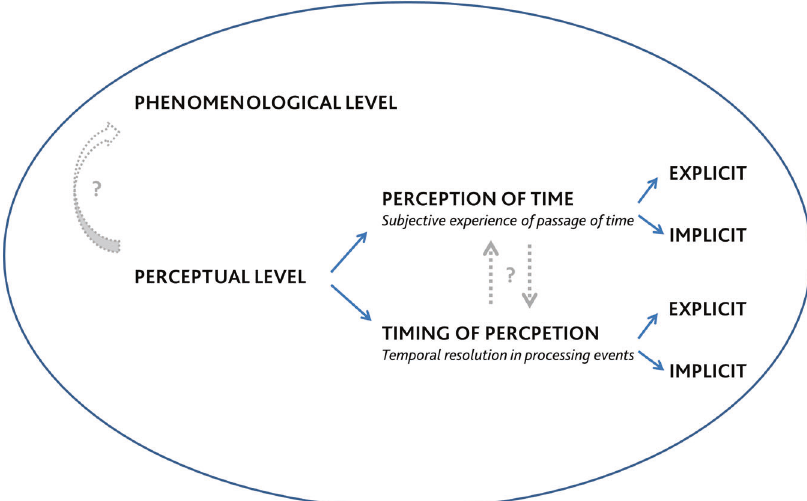
Fig. 1 The concept of time. Time involves both a phenomenological and a perceptual level. At perceptual level, it is possible to distinguish perception of time from timing of perception, which can both be investigated trough implicit or explicit experimental